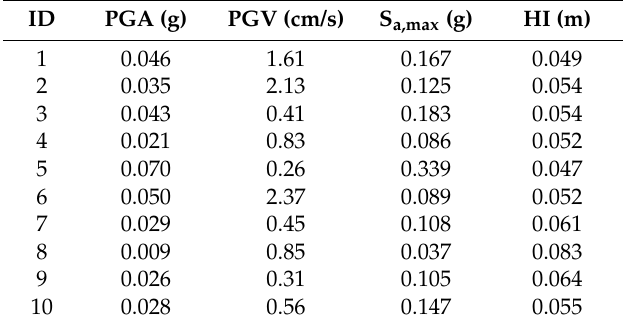
Table 2. Seismic parameters of the considered records in terms of peak ground acceleration (PGA) and velocity (PGV), maximum spectral pseudo-acceleration (S a,max ), and Housner Intensity.